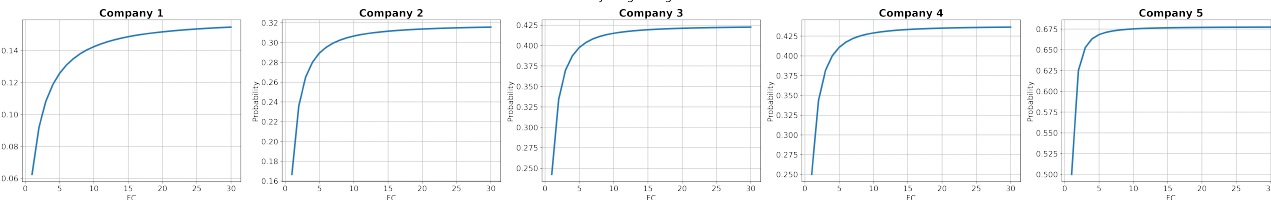
Figure 7. The figure shows for each FC the maximum probability of getting the first click of each client using the upper bound click rate approximation for each of them.